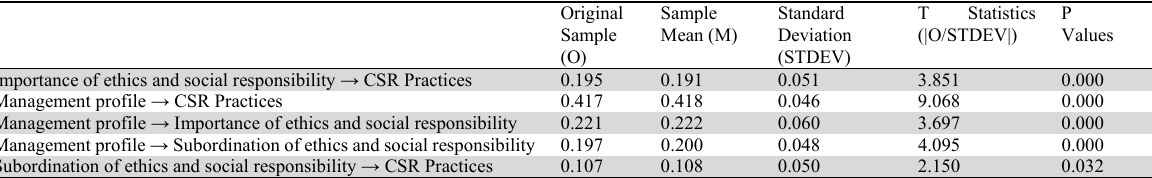
Mean, STDEV, T-Values, P-Values Importance of ethics and social responsibility → CSR Practices